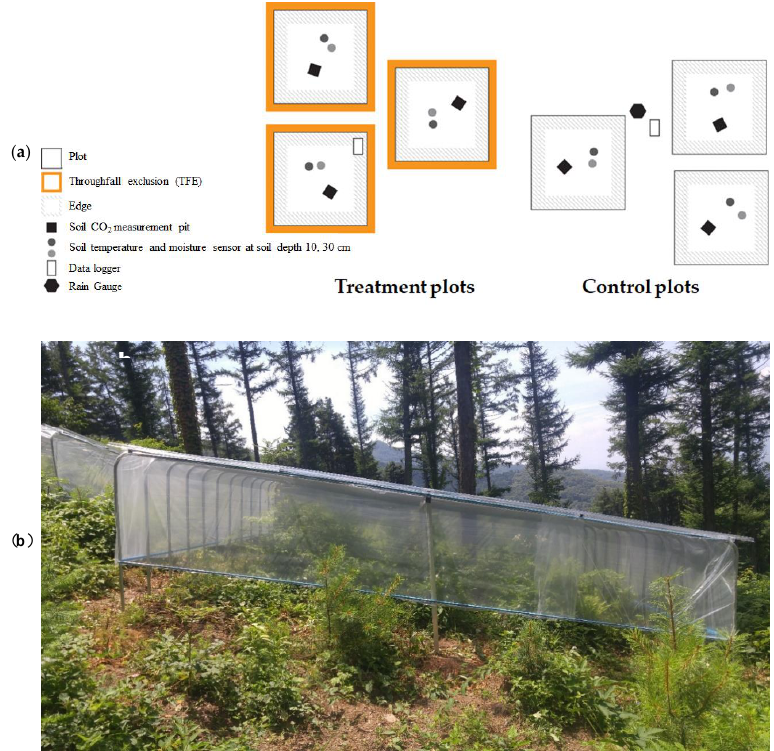
Figure 1. ( a ) Plot design of throughfall exclusion experiment. ( b ) Photograph of throughfall exclusion roof.